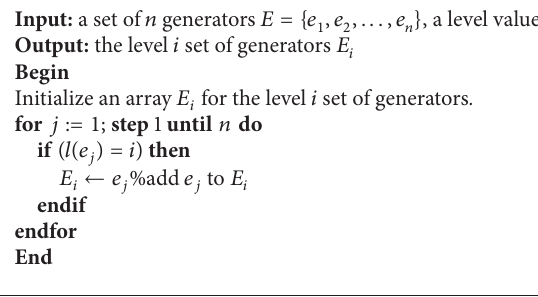
Algorithm 2: GetLevelGenerators